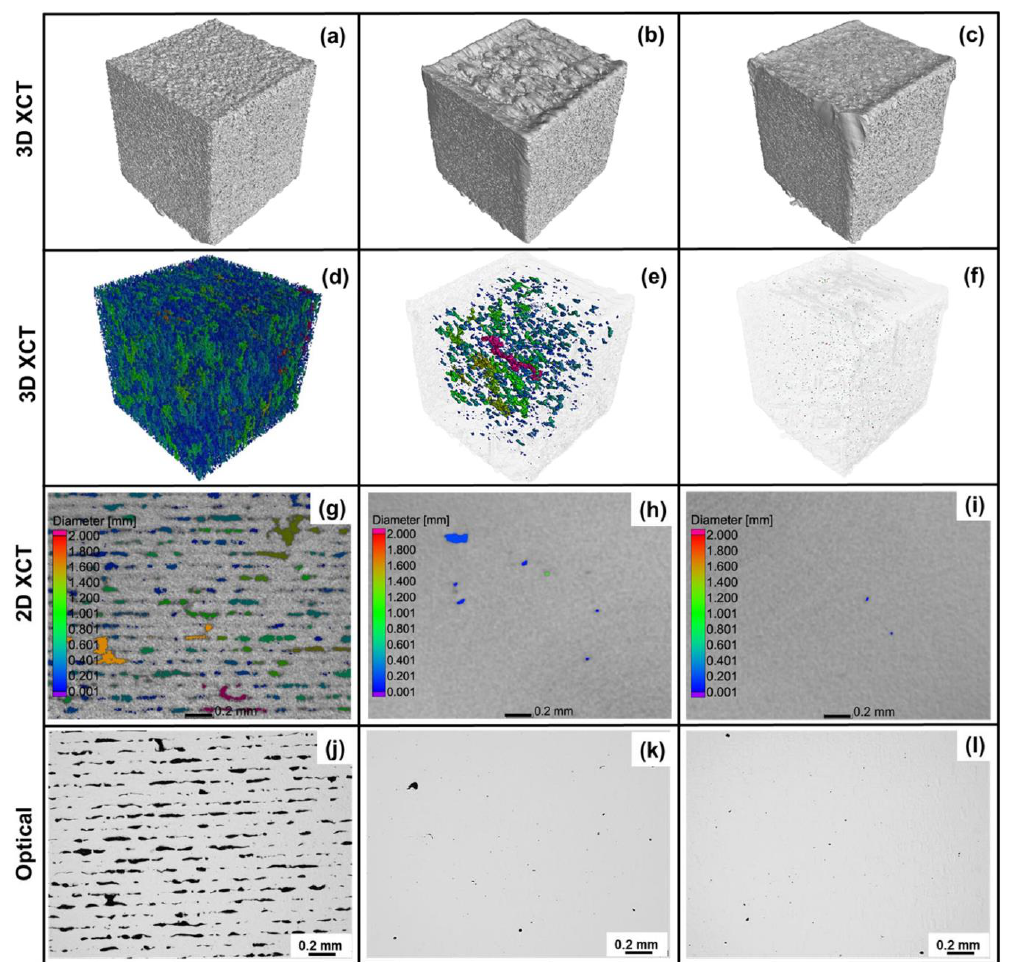
Figure 3. Porosity characterization for lack of fusion and keyhole parameter sets, including 3D XCT samples from lack of fusion pores to keyhole pores ( a – c ), 3D XCT porosity analysis ( d – f ), 2D XCT images ( g – i ) and 2D optical images ( j – l ). The pore coloring scale of 3D XCT is the same as those shown in 2D